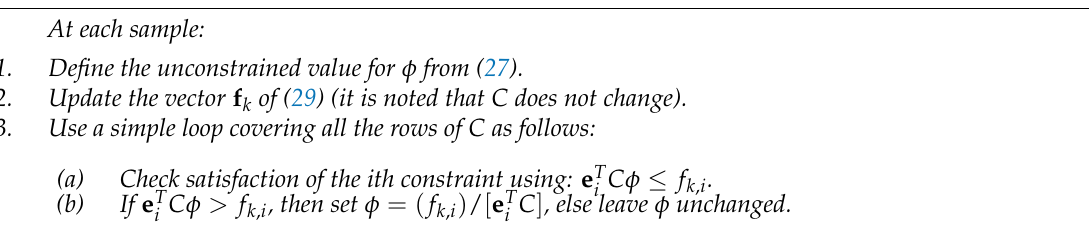
Algorithm 2. [PS-PFC with constraint